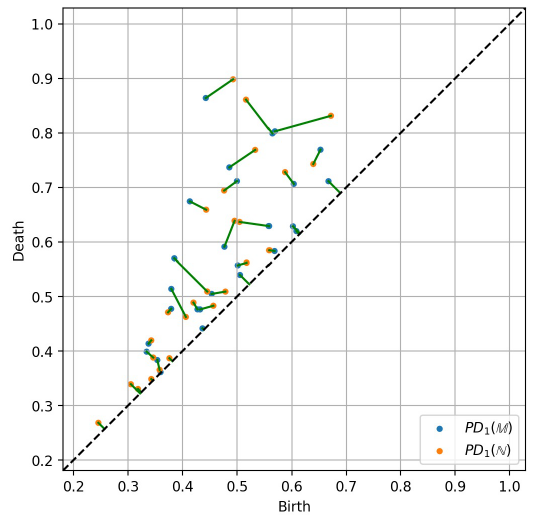
Figure 5. Optimal matching of two persistence diagrams PD 1 ( M ) and PD 1 ( N )